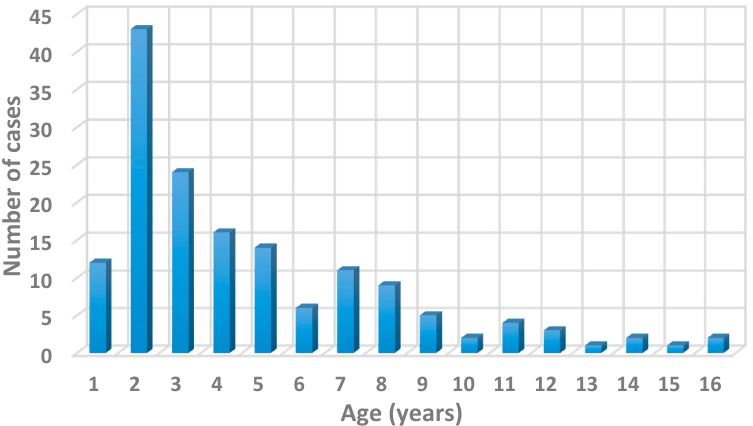
Figure 1. Distribution by age of 155 children with Salmonella enterica Typhimurium infection.